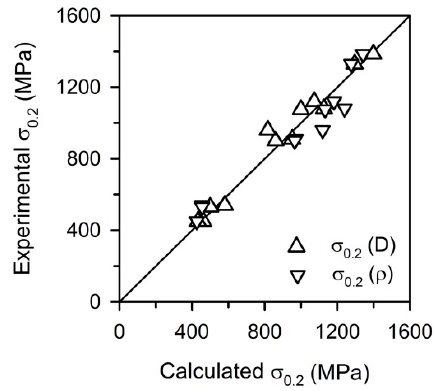
Figure 10. Relationship between the calculated and experimental yield strength ( σ 0.2 ) in a 316L-type stainless steel processed by cold or warm rolling and subsequent annealing.